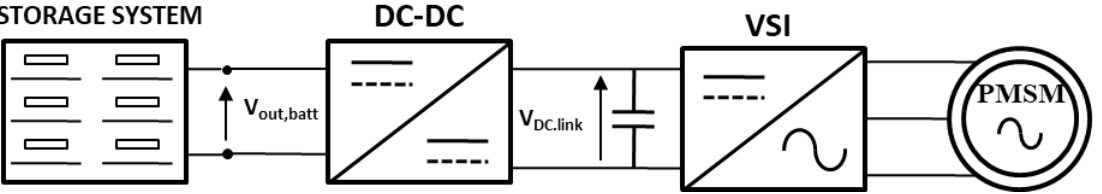
Table 5. Emissions results with Engine_3.